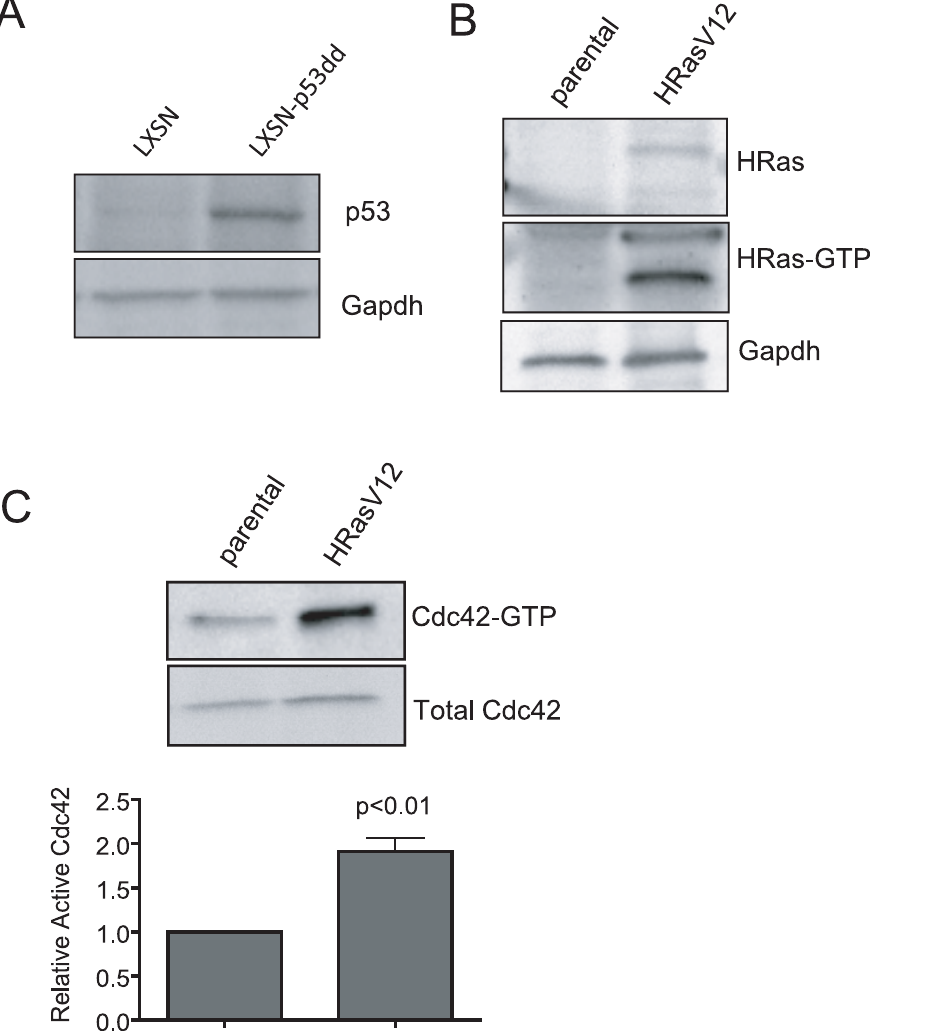
Figure 1. Cdc42 activity is increased upon Ras-mediated transformation. ( a ) Cell immortalization was achieved following retroviral transduction of cdc42 f/f cells with a dominant-negative p53 (p53dd). Dominant-negative expression was determined by western blot for p53. ( b ) Immortalized, cdc42 f/f cells were transformed through retroviral transduction with HRasV12. Transformed cells exhibit HRas overexpression and increased active, GTP-bound HRas as determined by pull-down with the ras binding domain (RBD) of Raf1 fused to GST. ( c ) HRasV12 transformed cells exhibit a significant increase in Cdc42 activity compared to non-transformed control cells. Pull-down assays were performed with GST-PAK1. The graphed data represents densitometry quantification from three independent